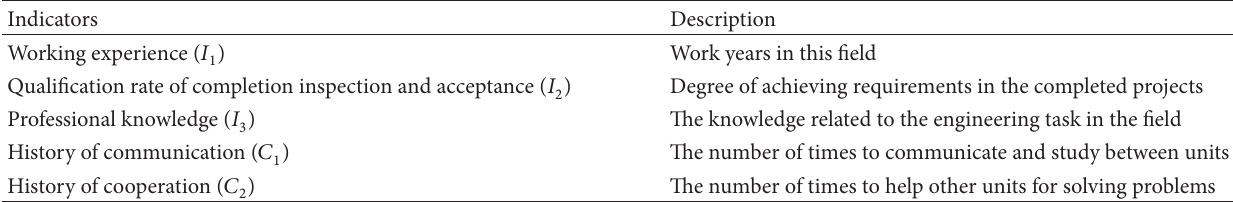
Table 1: Indicators system of project bidding.